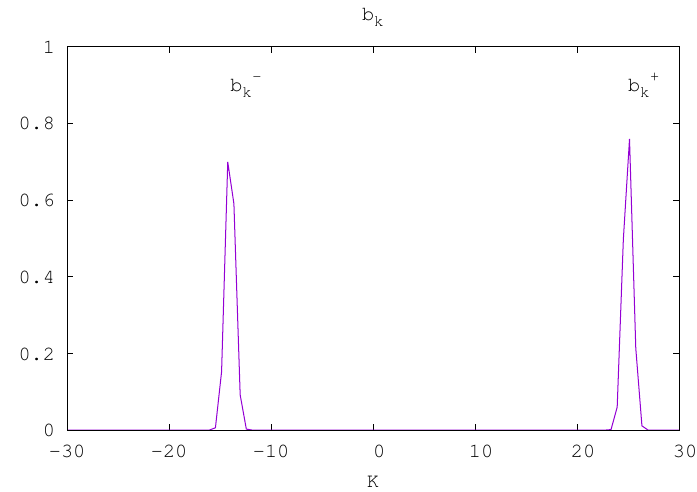
Figure 1. Two narrow bands spectra for two counter-streaming